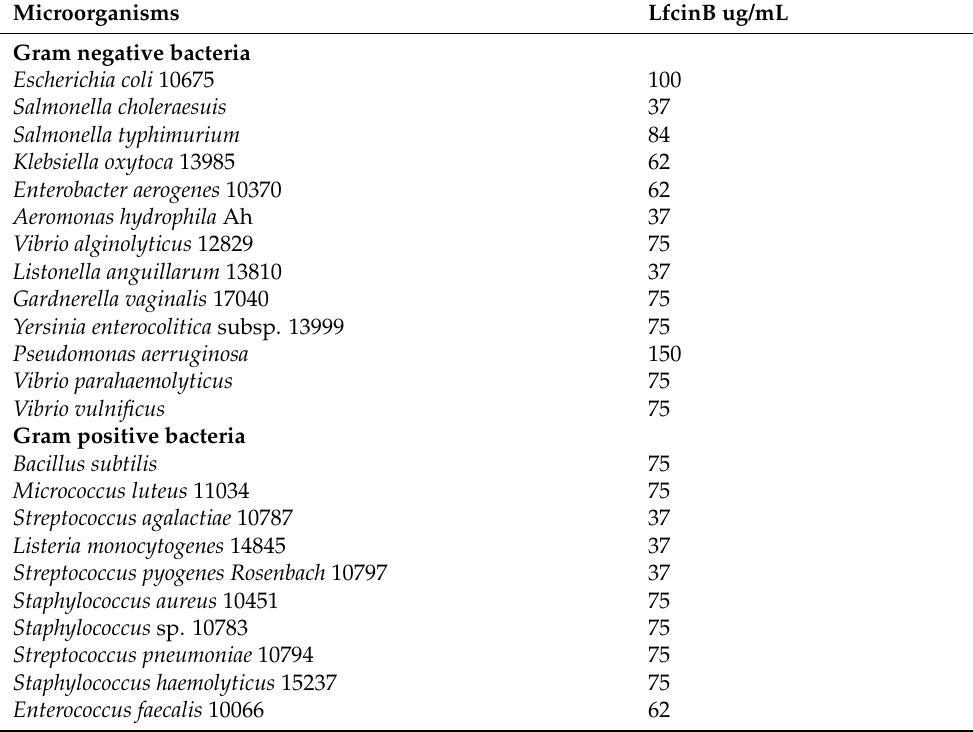
Table 1. Minimum inhibitory concentrations of LfcinB determined using microbroth dilution